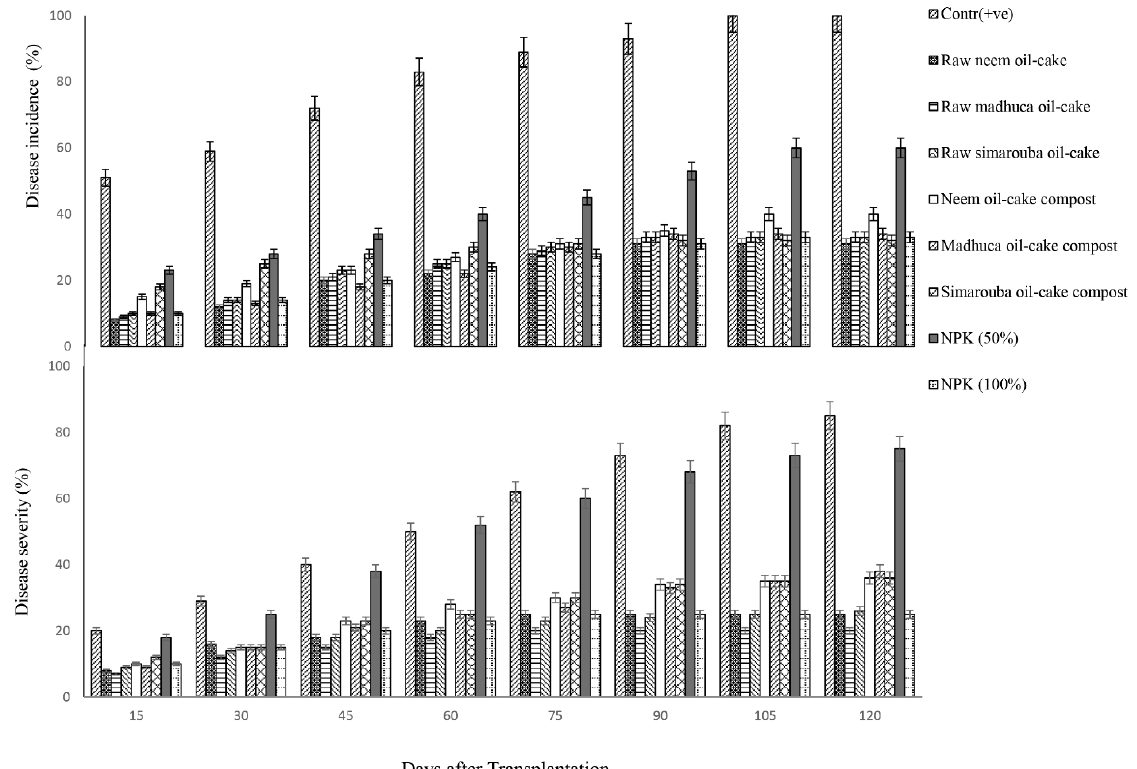
Fig. 3 Effect of soil amendment with raw or composted oil-cakes of neem, madhuca and simarouba on the inci- dence and severity (%) of leaf spot disease in chilli caused by Alternaria tenuissima in the